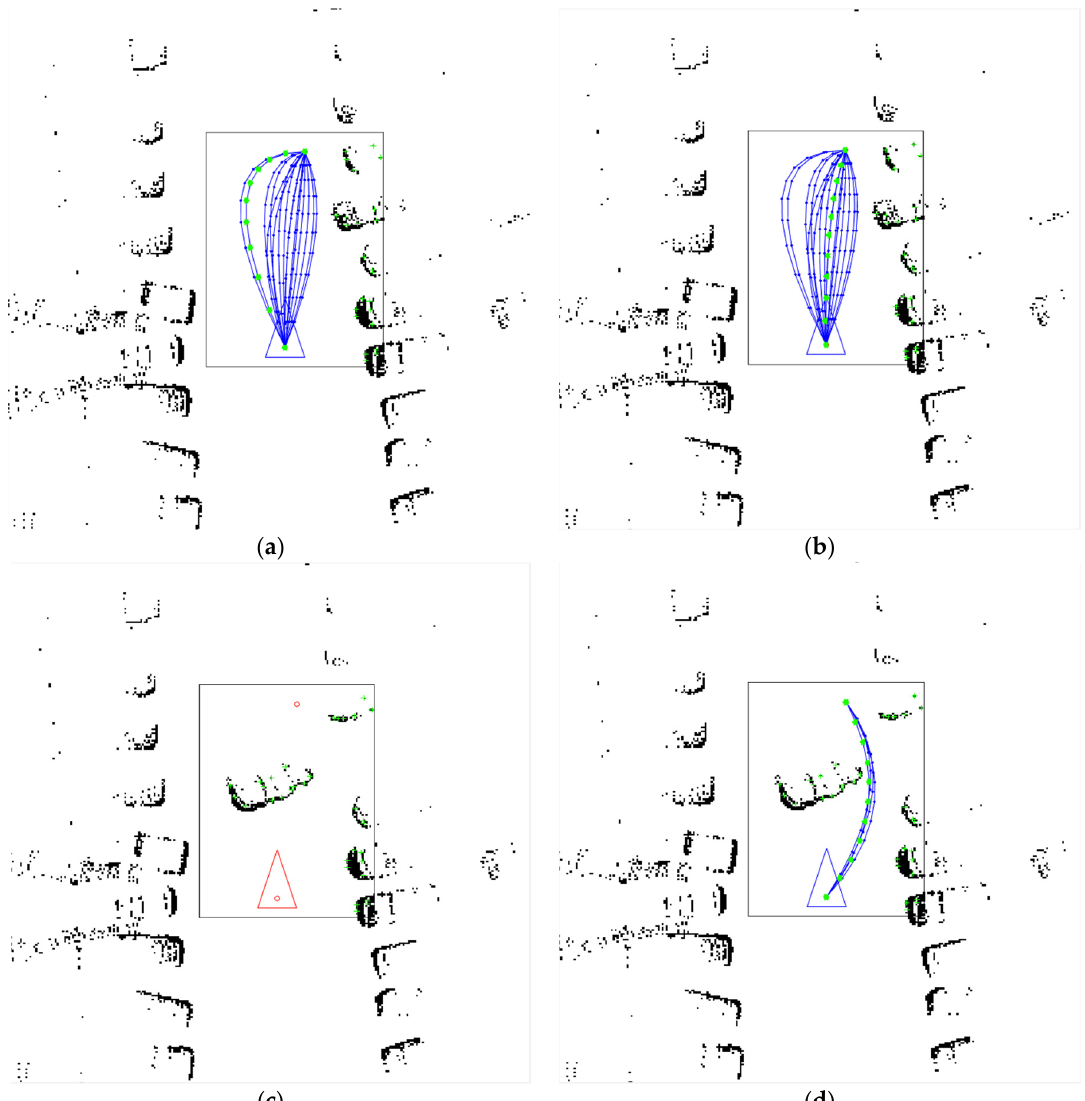
Figure 11. ( a ) Scenario 1 (nCurves = 30, safety distance = 1 m, criteria = maximum angle); ( b ) scenario 1 (nCurves = 30, safety distance = 1 m, criteria = medium trajectory); ( c ) scenario 4 (nCurves = 25, safety distance = 1 m, criteria = minimum distance); ( d ) scenario 4 (nCurves = 25, safety distance = 0.5 m, criteria = minimum distance).